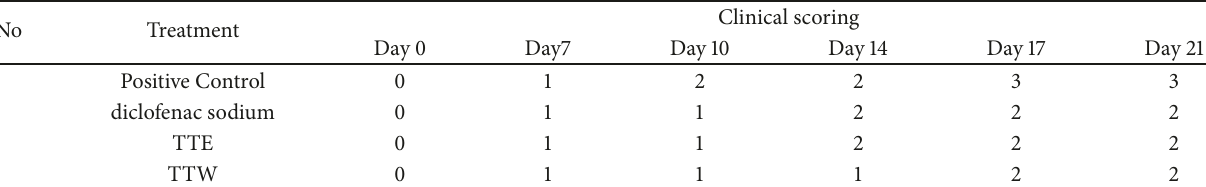
Table 2: Effect of TTE, TTW, and diclofenac on arthritic clinical scoring. Sl. No